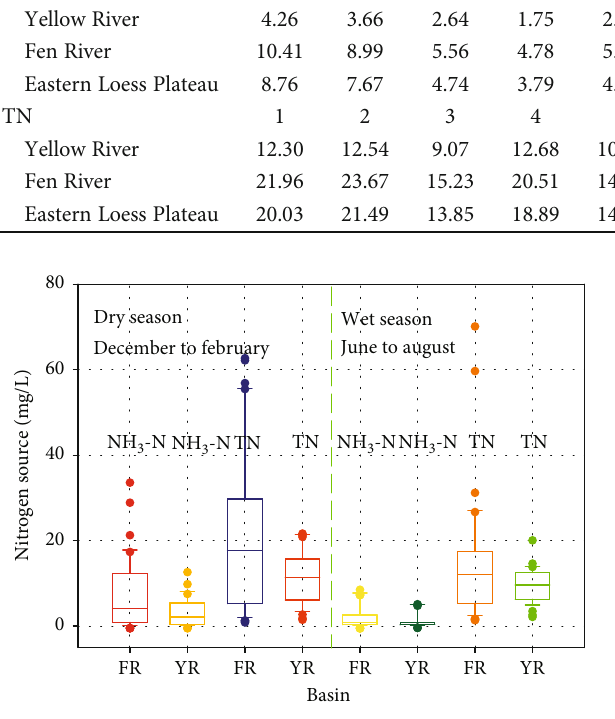
Figure 3: Temporal variations of NH dry and wet